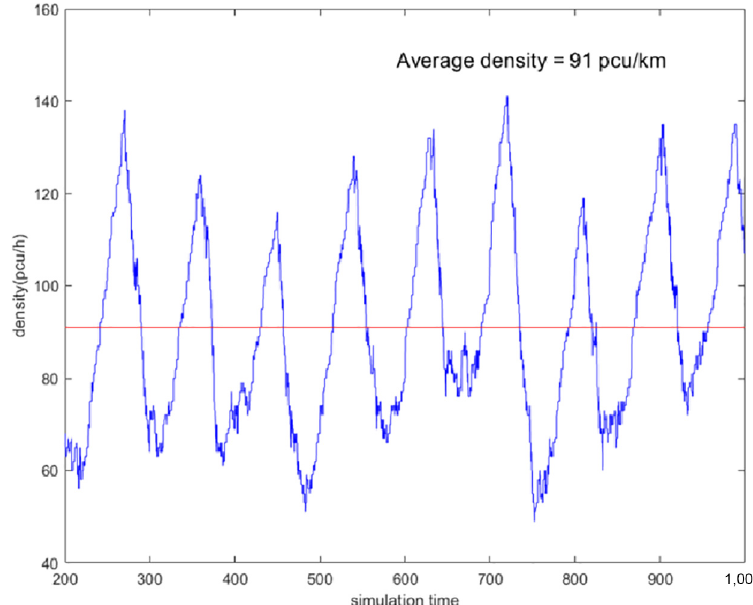
Figure 7 Real-time traf fi c density of the whole segment in ordinary traf fi c conditions